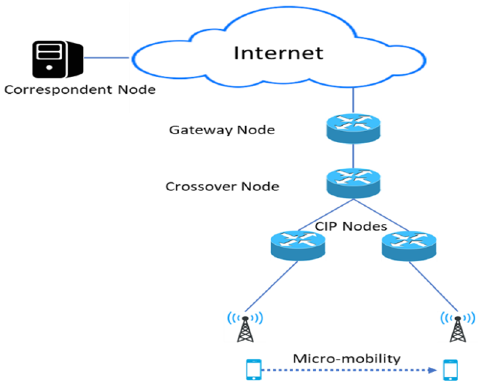
Figure 5. Cellular IP Architecture.